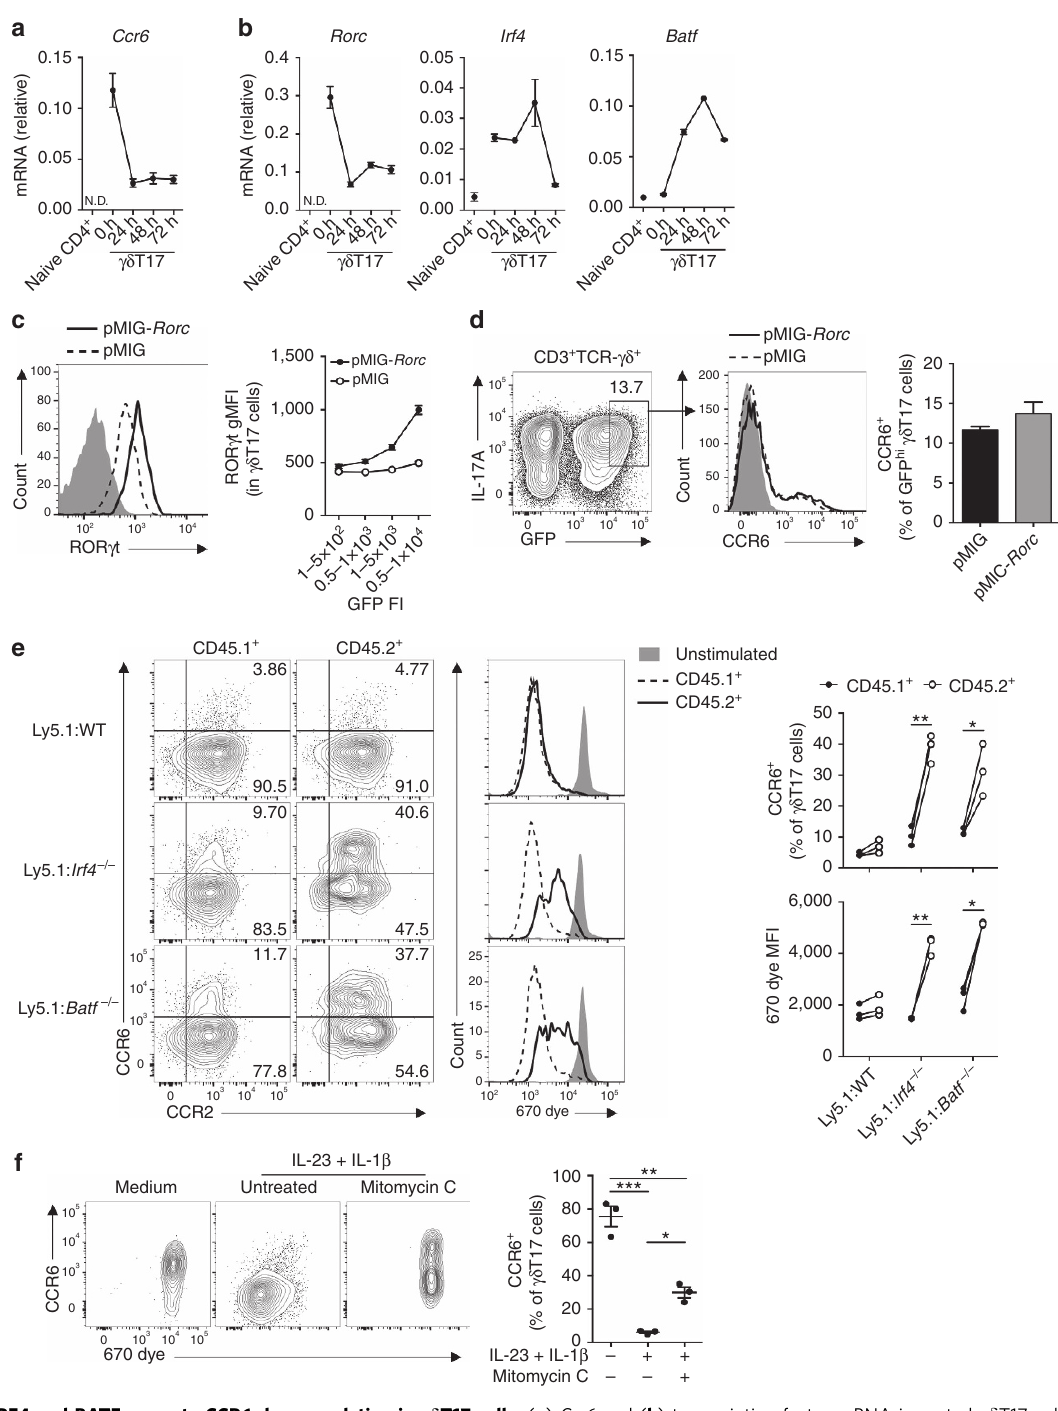
Figure 5 | IRF4 and BATF promote CCR6 downregulation in cd T17 cells. ( a ) Ccr6 and ( b ) transcription factor mRNA in sorted gd T17 cells from Il17a Cre (cid:3) Rosa26 eYFP lymphocytes ex vivo or cultured with IL-23/IL-1 b for indicated times (pooled from 5 to 7 mice). ND, not detected. ( c , d ) Expanded gd T17 cells ( n ¼ 3) were transduced with empty pMIG or pMIG- Rorc retrovirus. ( c ) Representative flow cytometry of ROR g t expression in GFP hi gd T17 cells (gated as in d ), relative to isotype (grey) and geometric mean fluorescence intensity (gMFI) relative to GFP fluorescence intensity (FI). ( d ) Representative flow cytometry of CCR6 expression and quantitation in GFP hi gd T17 cells. ( e ) Splenocytes from Ly5.1 and either wild type (WT), Irf4 (cid:2) / (cid:2) or Batf (cid:2) / (cid:2) mice were 670 dye-labelled, mixed 50:50 and stimulated with IL-23/IL-1 b for 72h. Representative flow cytometry and quantitation of CCR6 expression and proliferation in CD45.1 þ or CD45.2 þ gd T17 cells ( n ¼ 3/group). ( f ) Representative flow cytometry and quantitation of CCR6 expression by 670 dye-labelled gd T17 cells from WT splenocytes cultured with IL-23/IL-1 b for 72h with/without mitomycin C pre-treatment ( n ¼